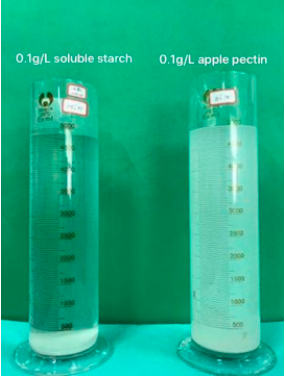
Figure 3. Experimental photo.